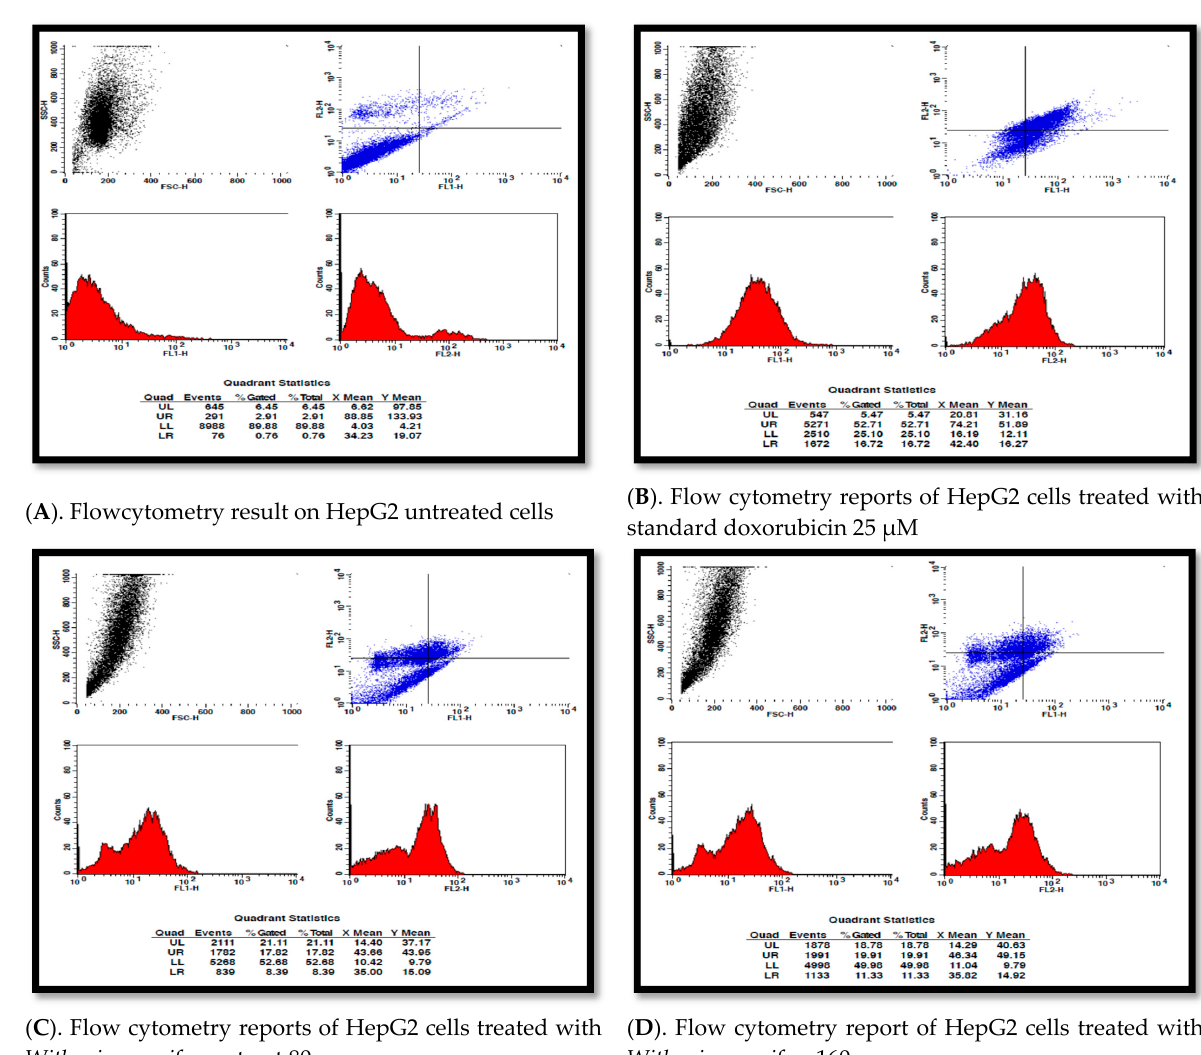
Molecules 2021 , 26 , x FOR PEER REVIEW Figure 9. ( A – D ) Report of apoptosis detection by flow cytometry. FL1 is PI and FL2 is FITC axis.